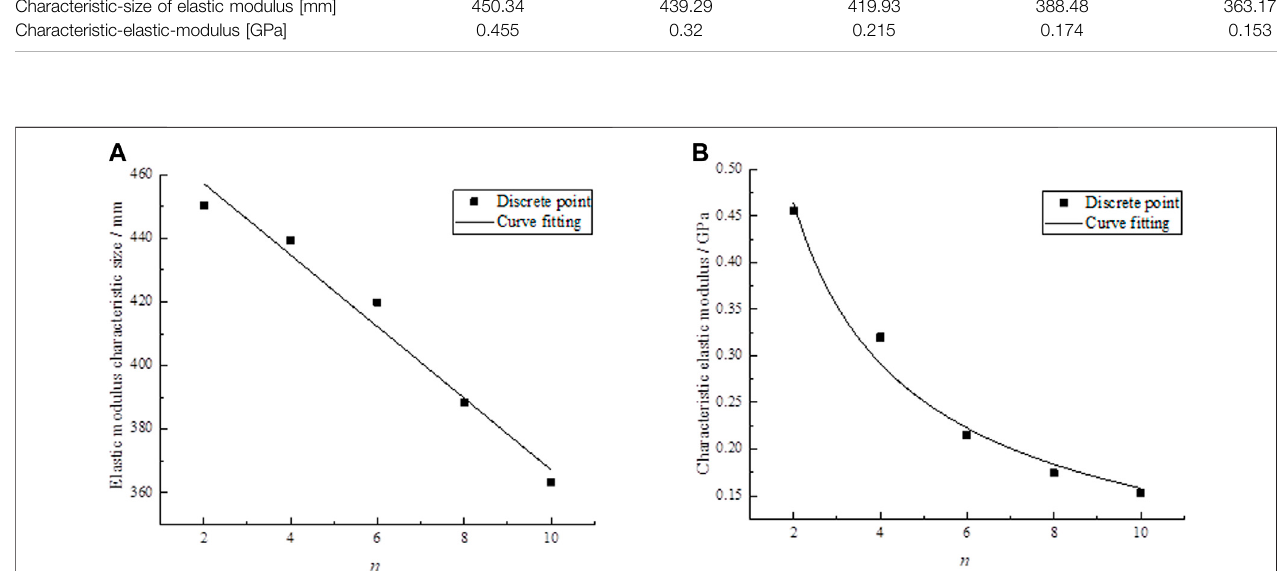
TABLE 5 | Relationship between characteristic-size of elastic modulus and number of parallel-joints. Number of parallel-joints